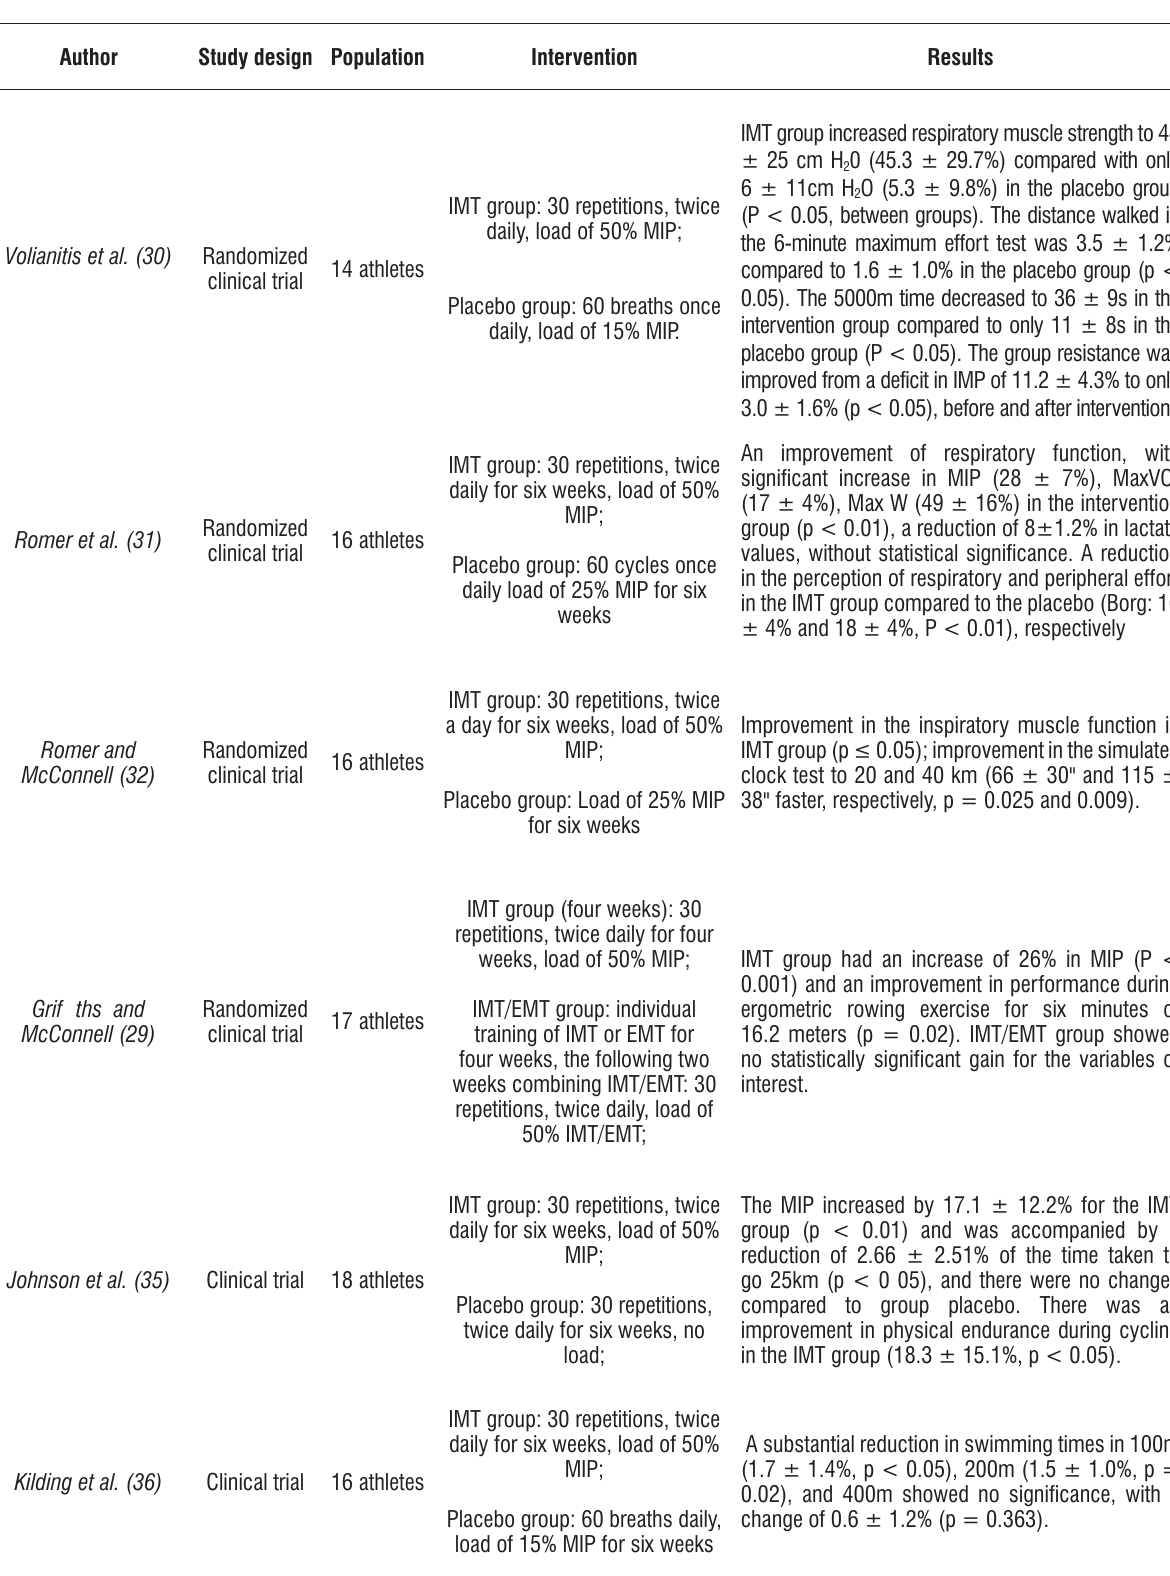
Table 3 - Benefits of Inspiratory muscle training (IMT) with Powerbreathe ® in association with sports